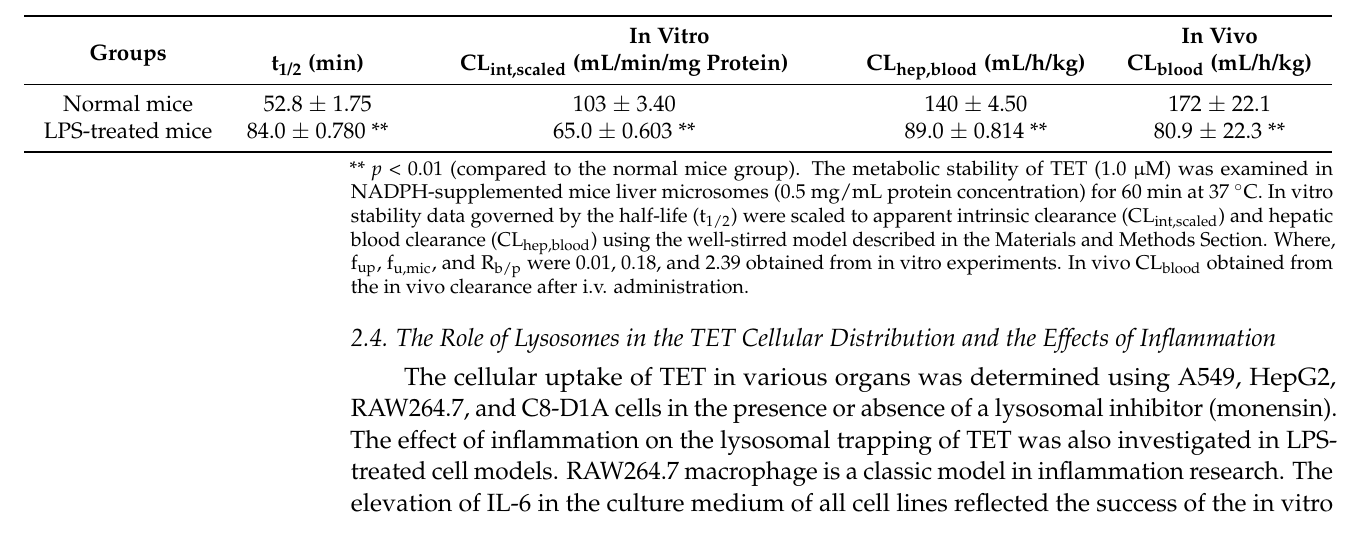
Figure 4. The activity of CYP3A in normal and LPS-induced ALI mice liver and lung microsomes. ( A ) The metabolic transformation velocity of midazolam and testosterone to 1-OH-Midazolam and 6 β -OH-Testosterone in normal and LPS-induced ALI mice liver and lung microsomes ( n = 3, Mean ± SD, ** p < 0.01 compared to the normal mice group). ( B ) The metabolic stability of TET in normal and LPS-induced ALI mice liver and lung microsomes ( n = 3, Mean ± SD). Table 3. The metabolic stability of TET in normal and LPS-induced ALI mice liver microsomes ( n = 3, Mean ± SD) correlated with in vivo observed clearance ( n = 6, Mean ± SD).